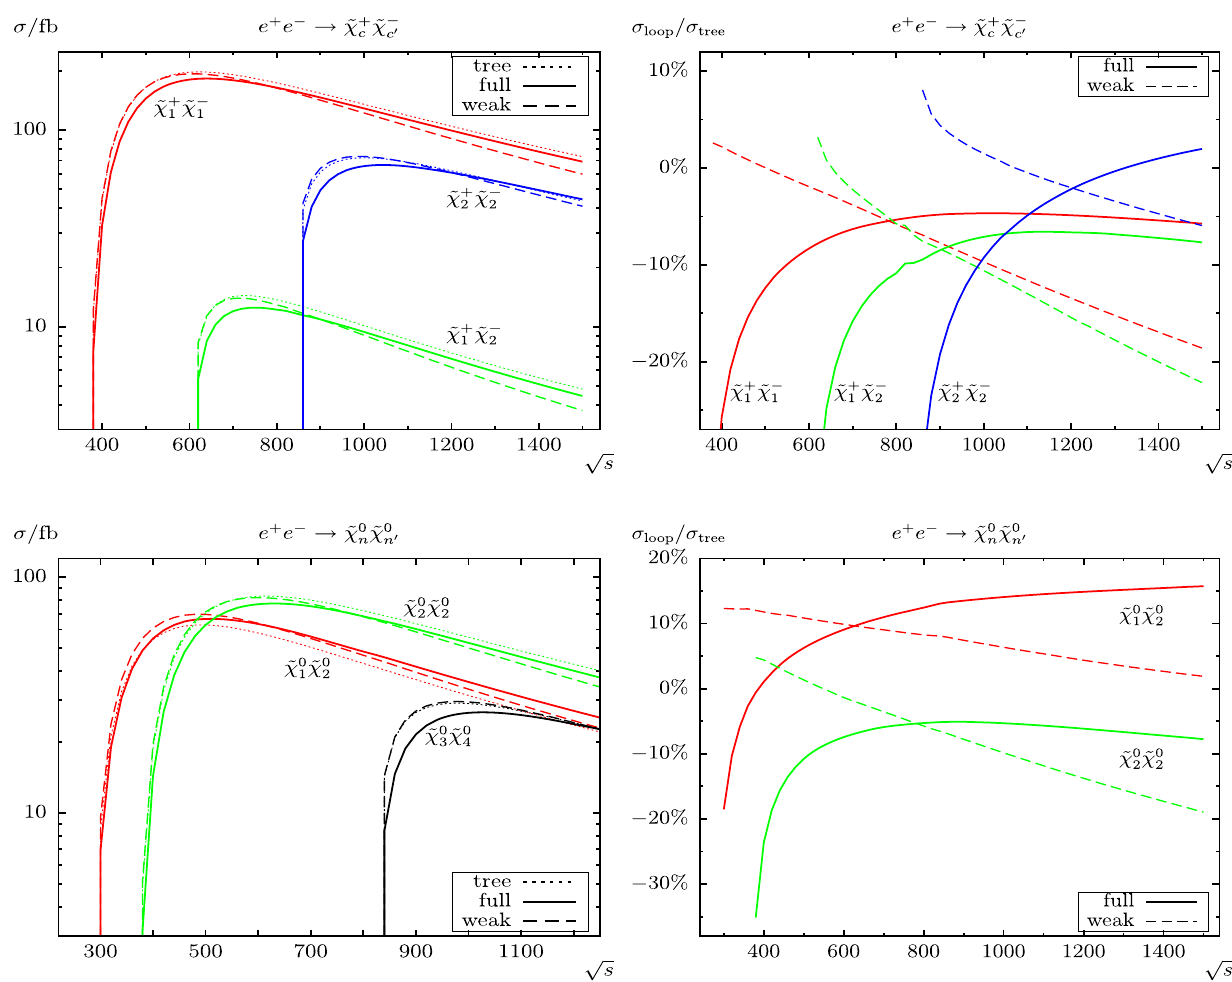
˜ χ 0 ) (lower row). The left (right) plot shows cross n n (cid:4)